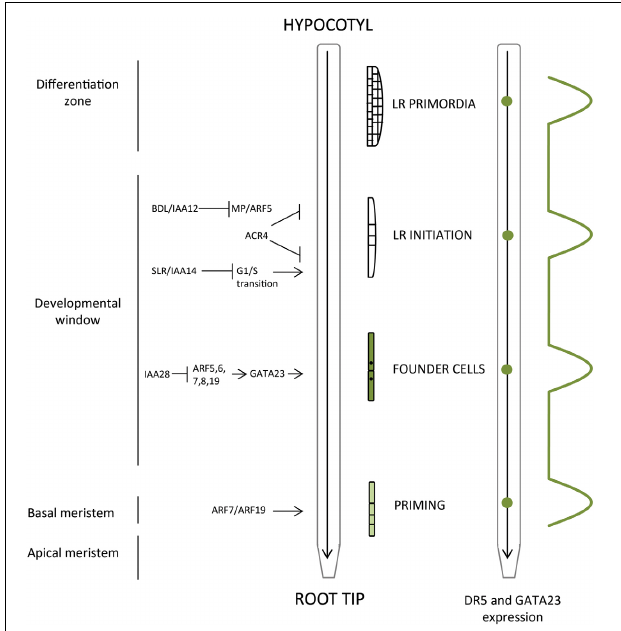
FIGURE 1 | Spatiotemporal control of lateral root organogenesis in primary root. Priming of LRP precedes LR initiation and occurs in the basal meristem. Developmental window defines the occurrence of the FC establishment and most distal LRI, and LRPs develop and emerge through adjacent tissues in the differentiated part of the root. Correlation between the root zones (apical and basal meristem, developmental window, differentiation zone) with phases of LR development (priming, founder cells, LR initiation, LR primordia) along with the main molecular events are presented. The oscillatory mechanism that determines LR positioning as reported by DR5::LUC (auxin response marker) and GATA23 is depicted (green